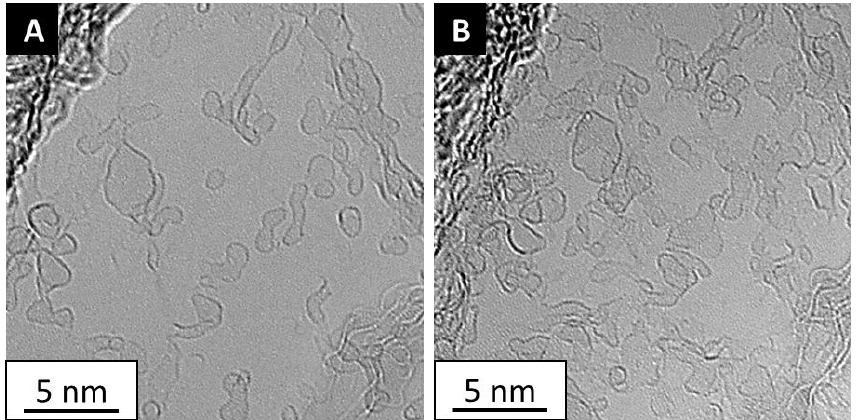
Figure 1. Transmission electron microscope (TEM) micrographs showing the accumulation of column contamination over time. Panel ( A ) Graphene at time = 0, Panel ( B ) Graphene at time = 20 min. The graphene was kept in the TEM column without irradiation for 20 min. The accumulation of contamination on the graphene is obvious. Data collected on an FEI Cs double corrected Titan 3 at 80 kV.